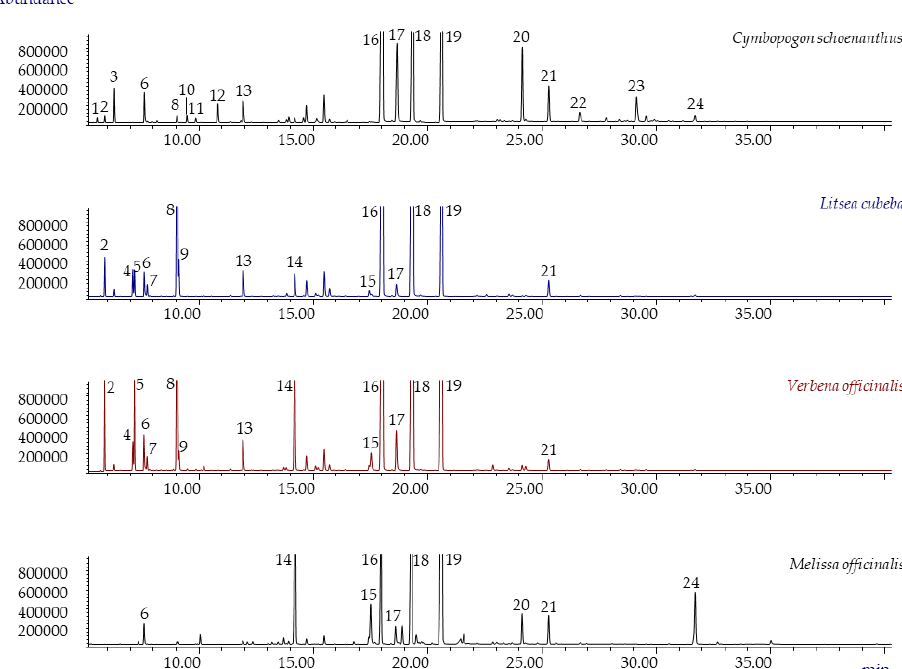
Figure 1. GC-MS profiles of Cymbopogon schoenanthus ( batch 2020), Litsea cubeba ( batch 2020), Verbena officinalis ( batch 2020), and Melissa officinalis 1 essential oils. Legend: (1) tricyclene, (2) α -pinene, (3) camphene, (4) sabinene, (5) β -pinene, (6) 6-methyl-5-hepten-2-one, (7) β -myrcene, (8) limonene, (9) 1,8-cineole, (10) cis - β -ocimene, (11) trans - β -ocimene, (12) 4-nonanone, (13) linalool, (14) citronellal, (15) nerol, (16) neral, (17) geraniol, (18) geranial, (19) ISTD (C13), (20) geranyl acetate, (21) trans -β-caryophyllene, (22) trans -isoeugenol, (23) γ-cadinene, (24) caryophyllene oxide. For analysis conditions, see Section 3.4.